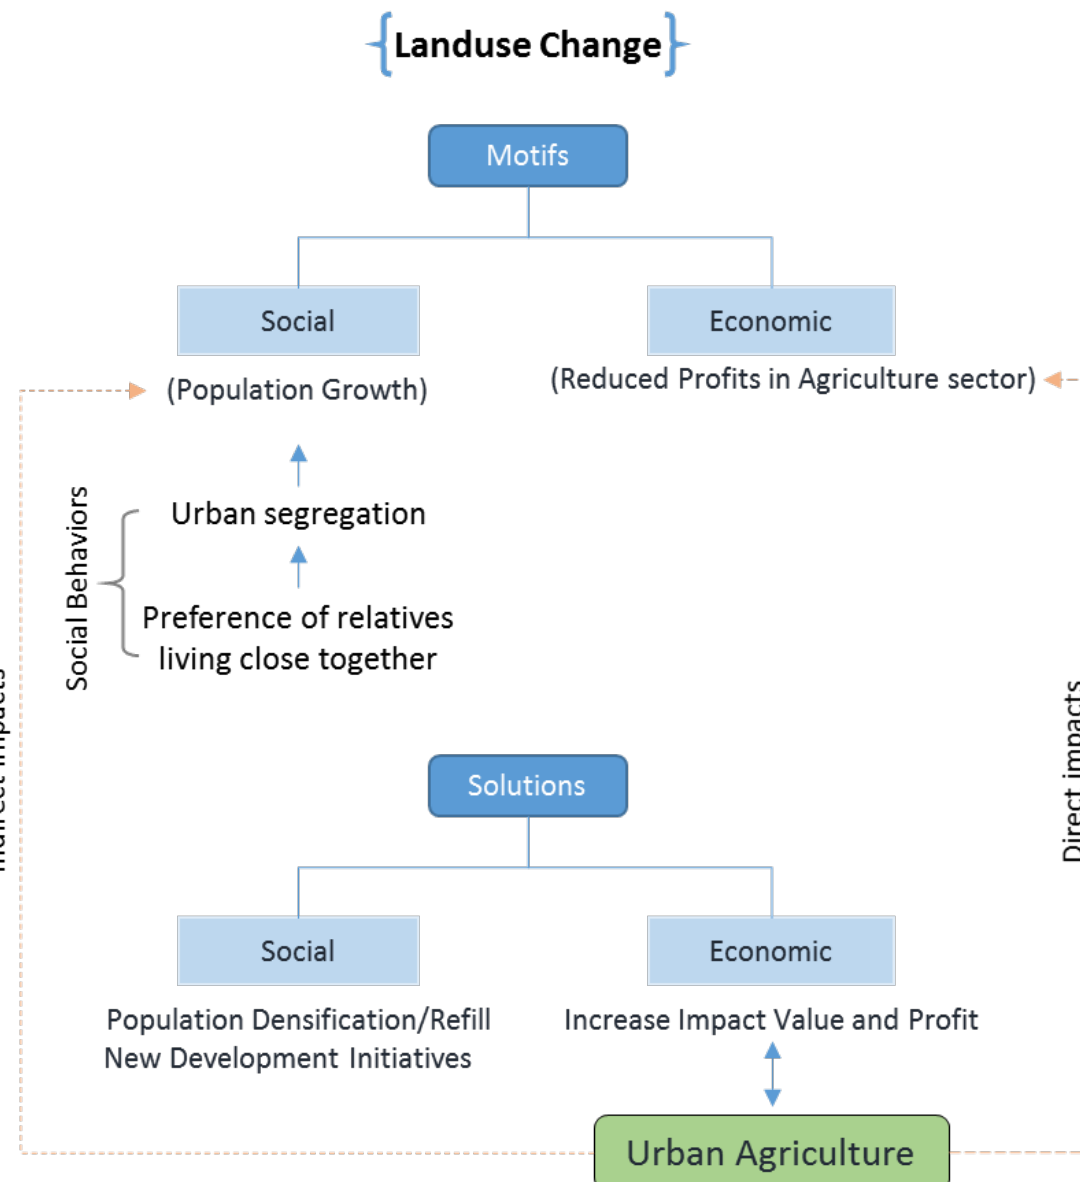
Figure 4. Urban Agriculture as a feasible